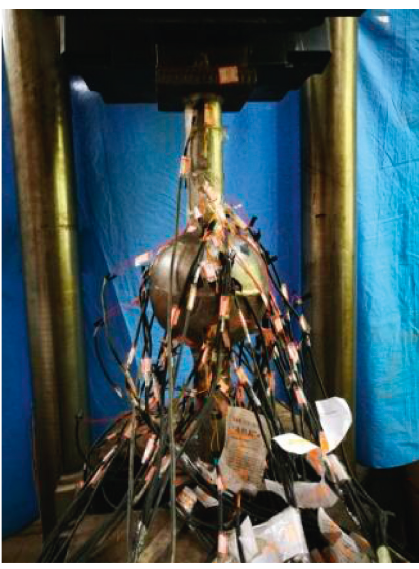
Figure 5: Tension machine for the static load